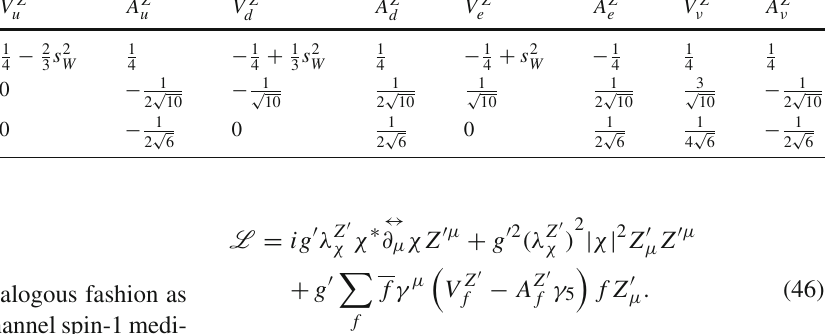
Table 1 Table of couplings between the SM fermions and a Z (cid:15) (see Eq. (46)) for the three different realizations of a Z (cid:15) ≡ sin 2 θ portal. Here s 2 W